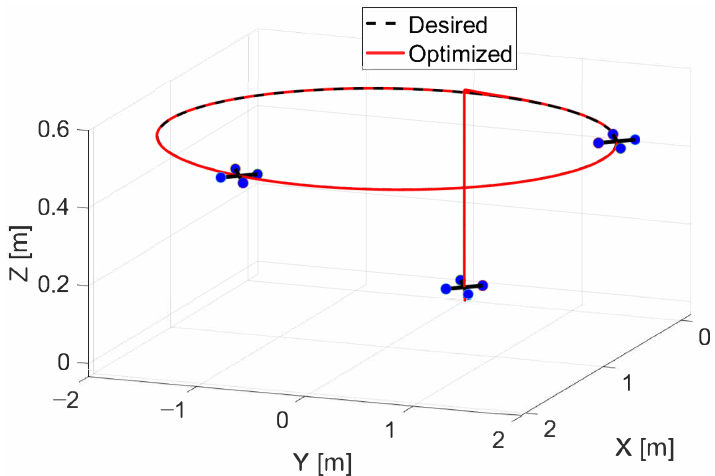
Figure 24. Tracking performance in three–dimensional space changing desired trajectory. The optimized parameters of PID controller obtained and HGS algorithm with 100